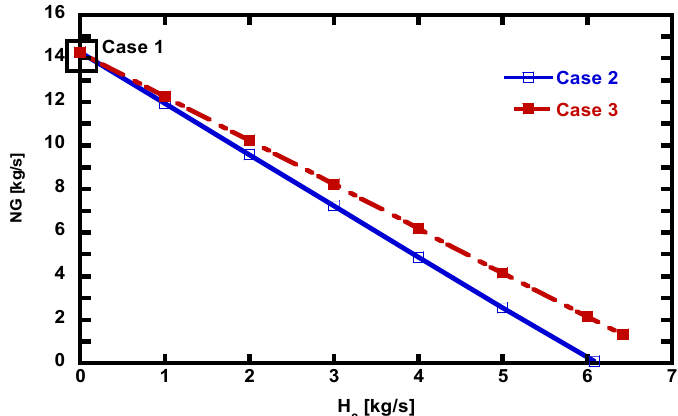
Figure 8. Variation in NG consumption according to H 2 usage.